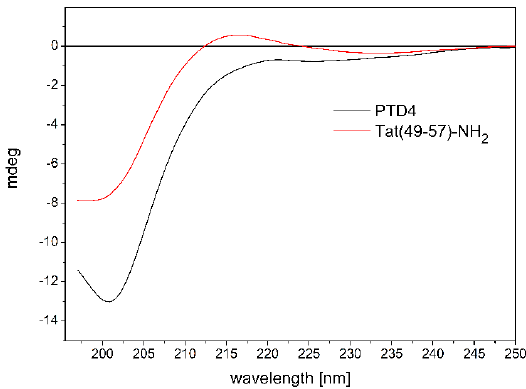
Figure 1. CD spectra showing the influence of Ala-scan substitution (Lys 50,51 ,Arg 52,55,57 → Ala) on the conformational properties of Tat(49–57)-NH 2